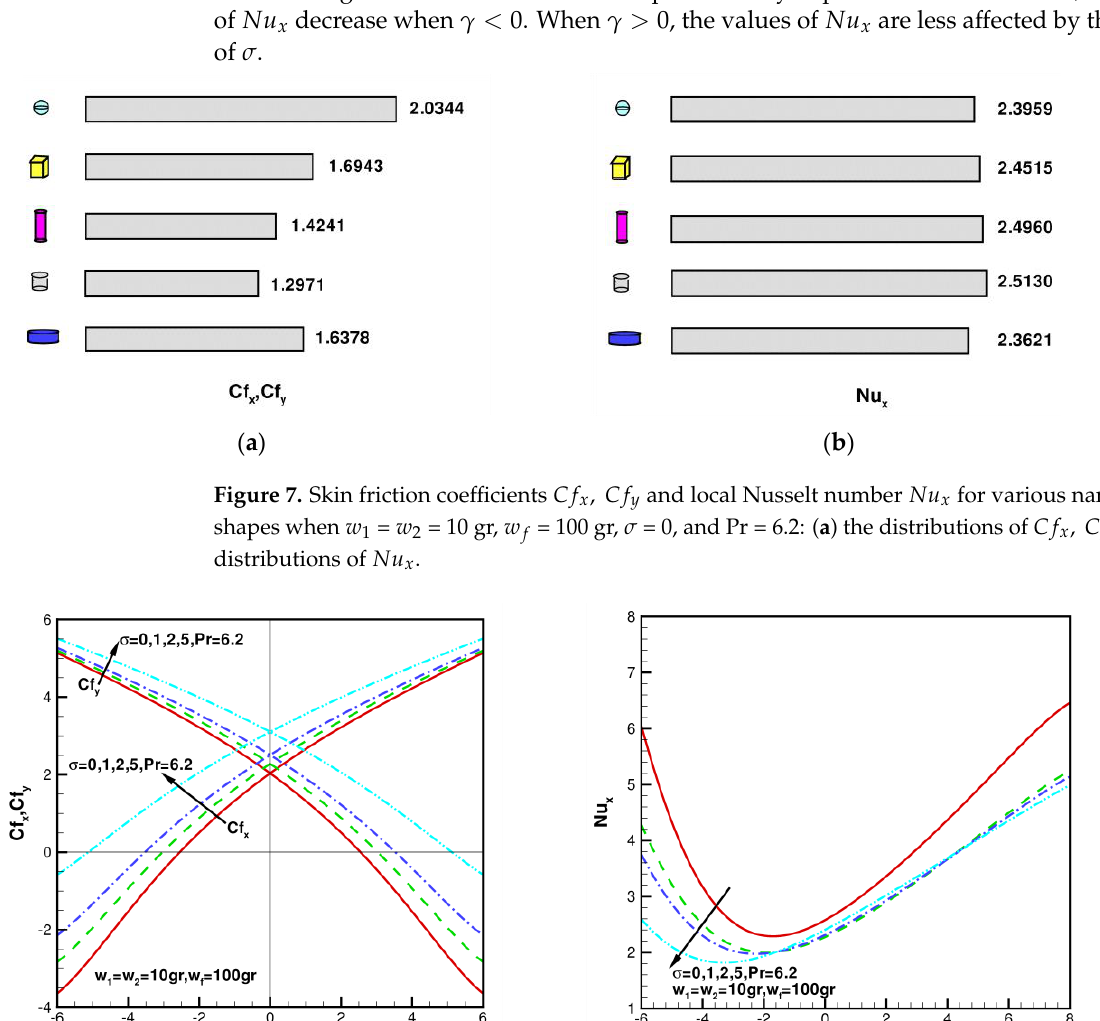
Figure 7. Skin friction coefficients